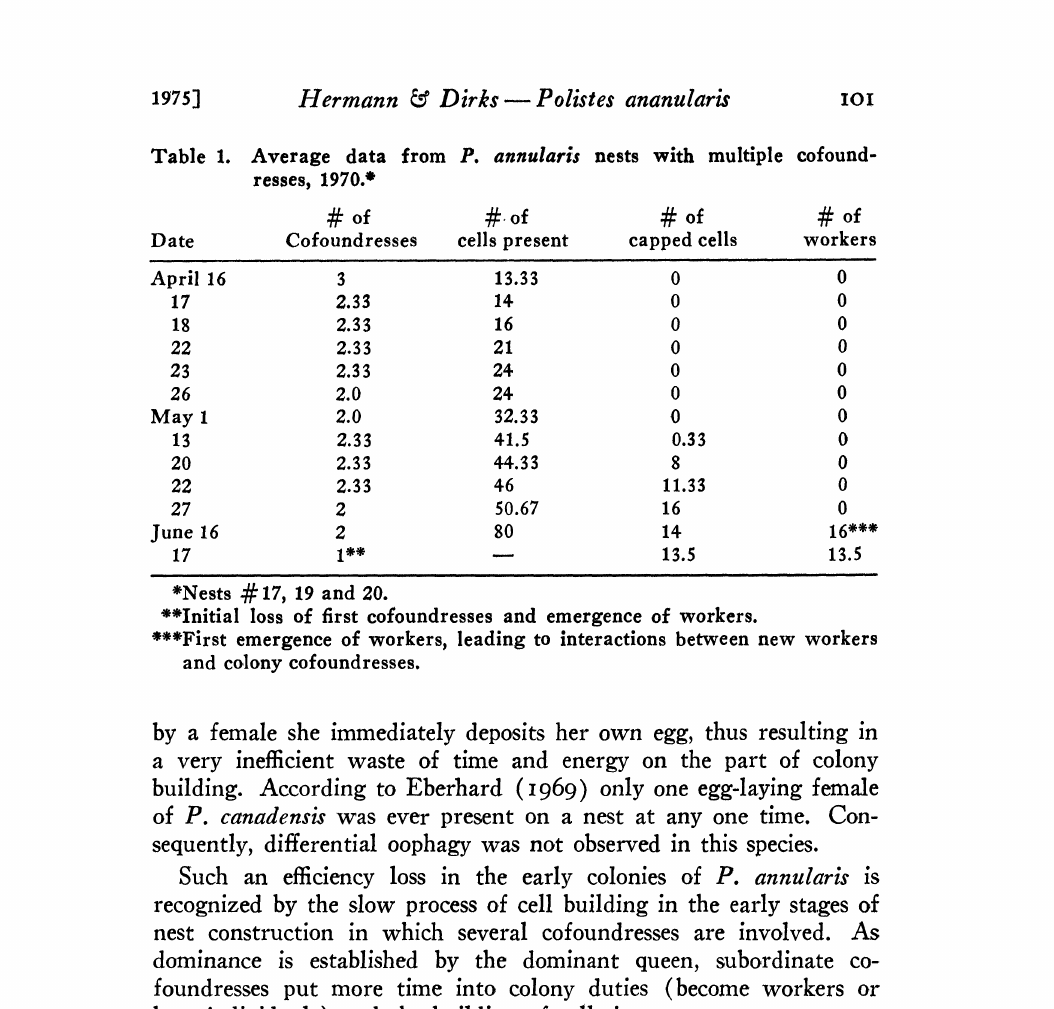
Table 1. Average data from P. annularis nests with multiple cofound- resses, 1970.* # o # o # o #